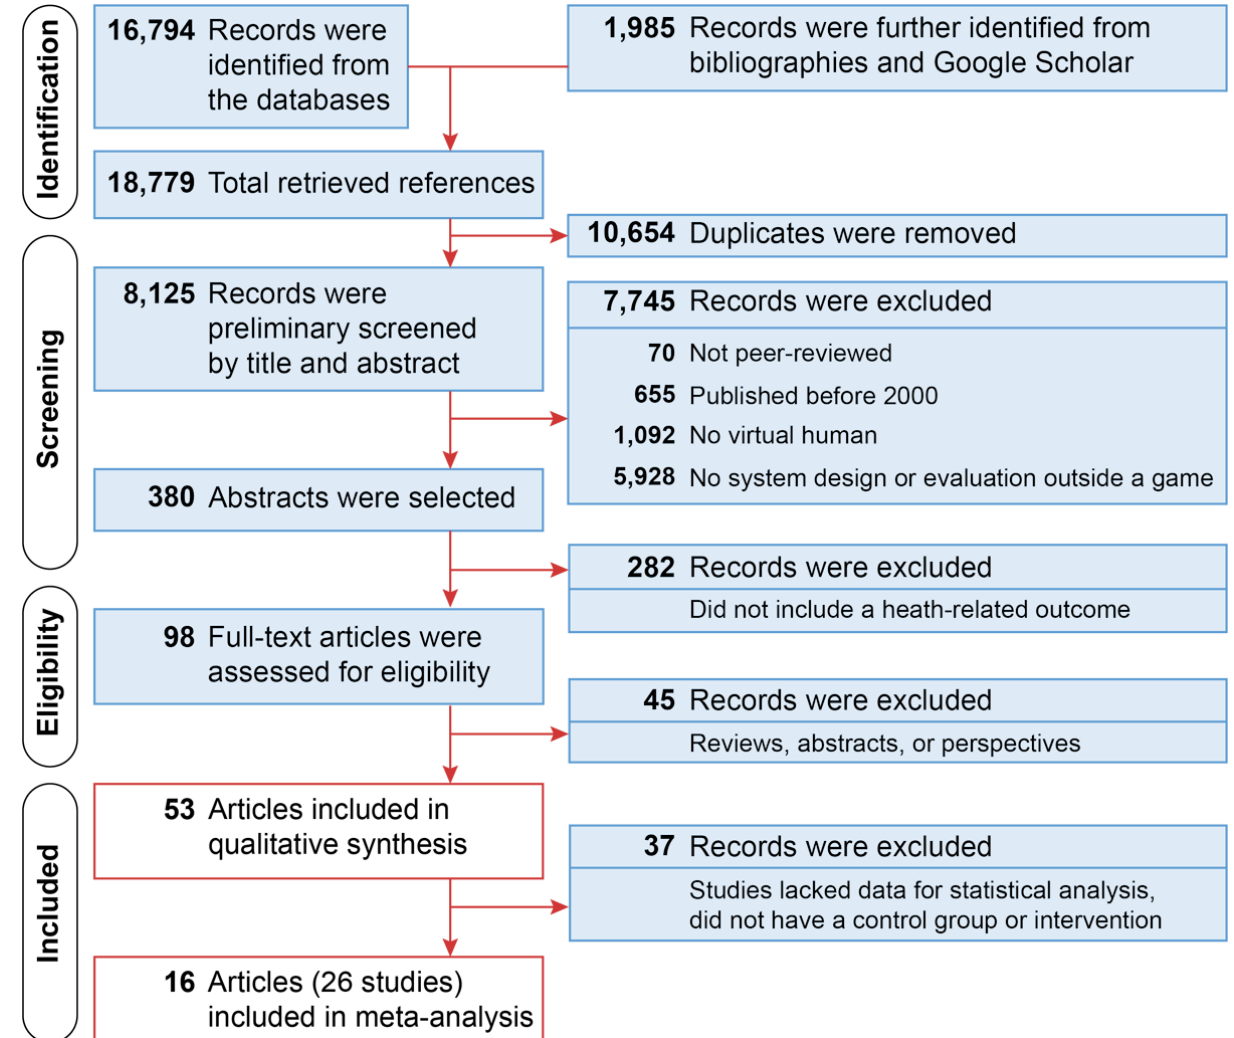
Figure 1. Summary of the literature